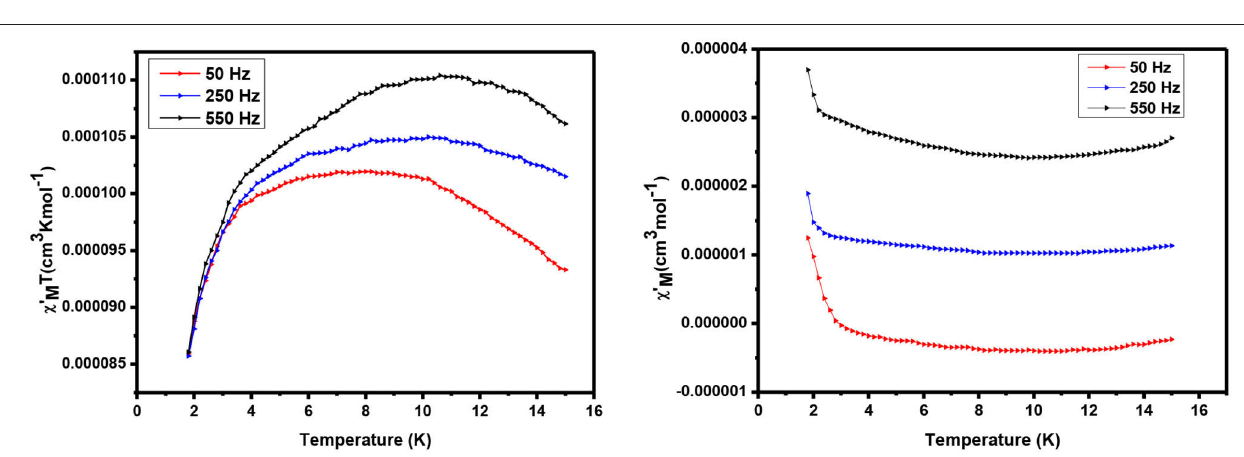
mmol) in MeCN (10 mL). The reaction mixture was kept stirring, and solid Co(NO 3 ) 2 · 6H 2 O (0.037g, 1 mmol) was added